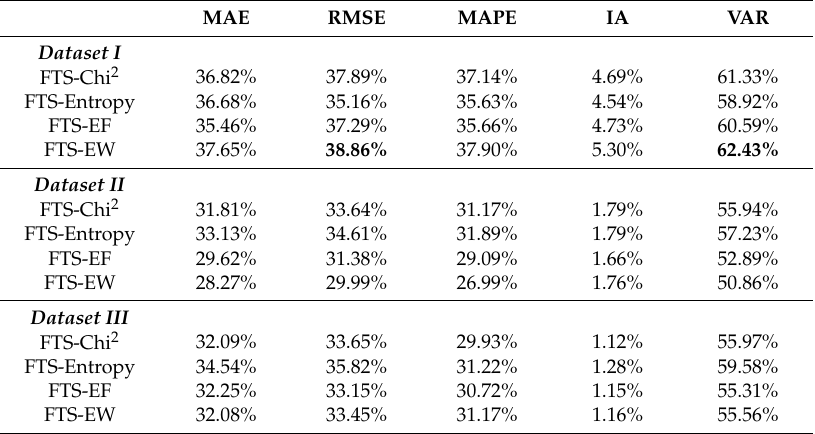
Table 7. Improvement ratios of the different error criteria for the pre-processing